Question: What form of chart is displayed?
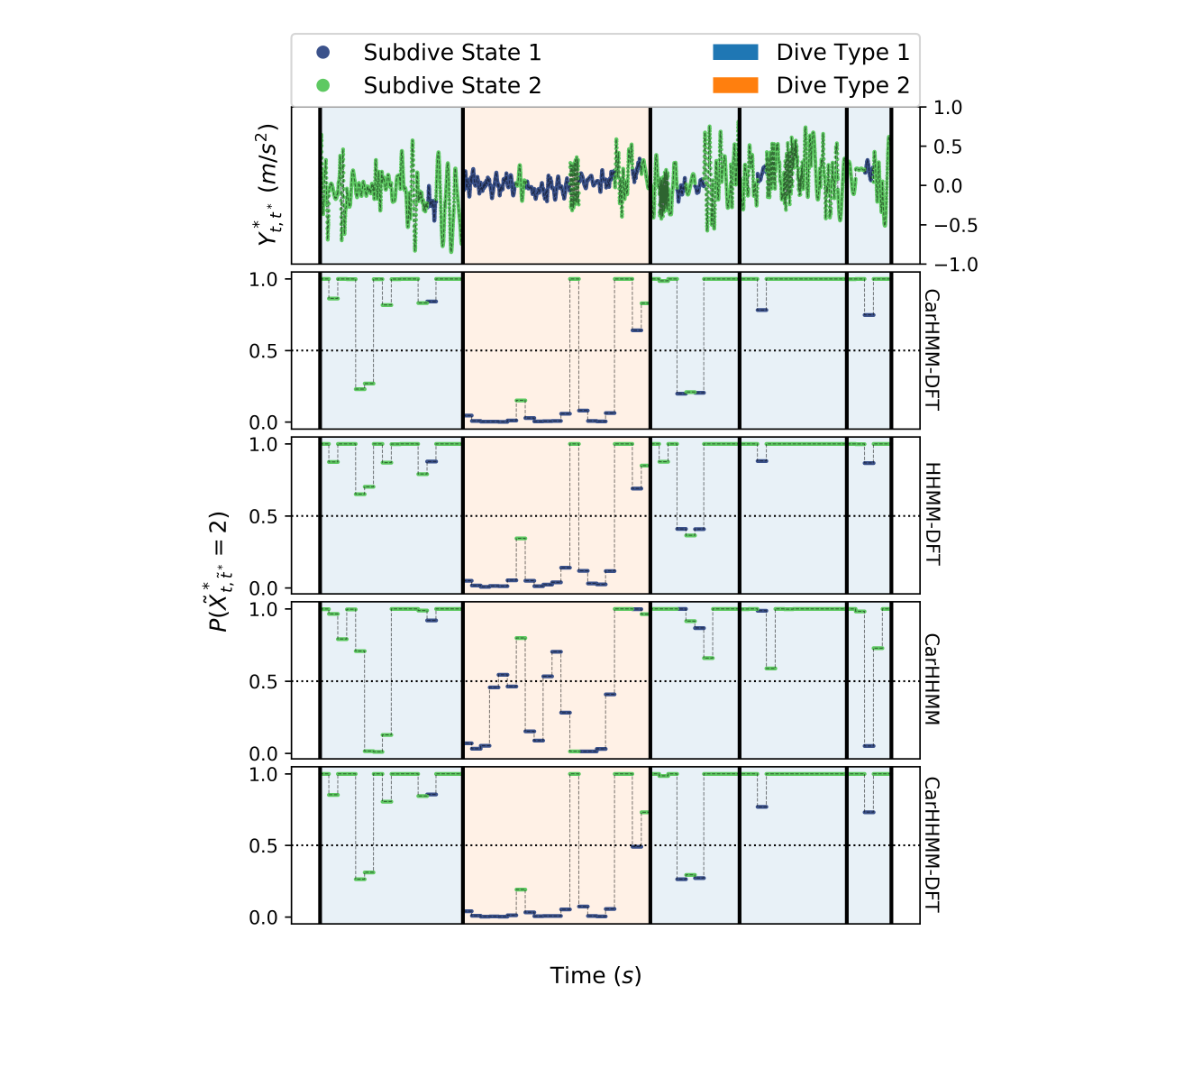
Answer: line